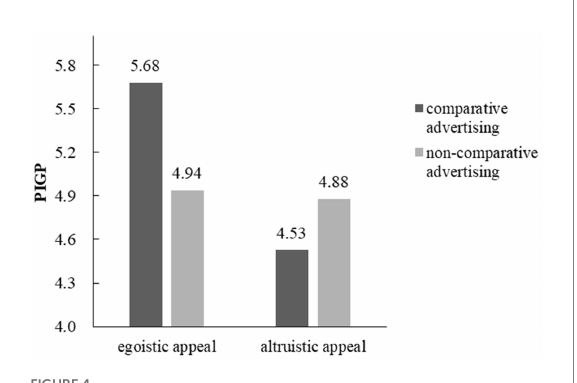
FIGURE 5 The interaction effect between advertising types and advertising appeals on perceived diagnosticity.